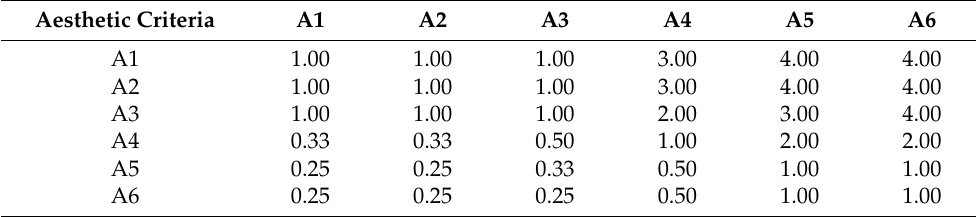
Table 7. Domination matrix of aesthetic criteria of PV. Own study.